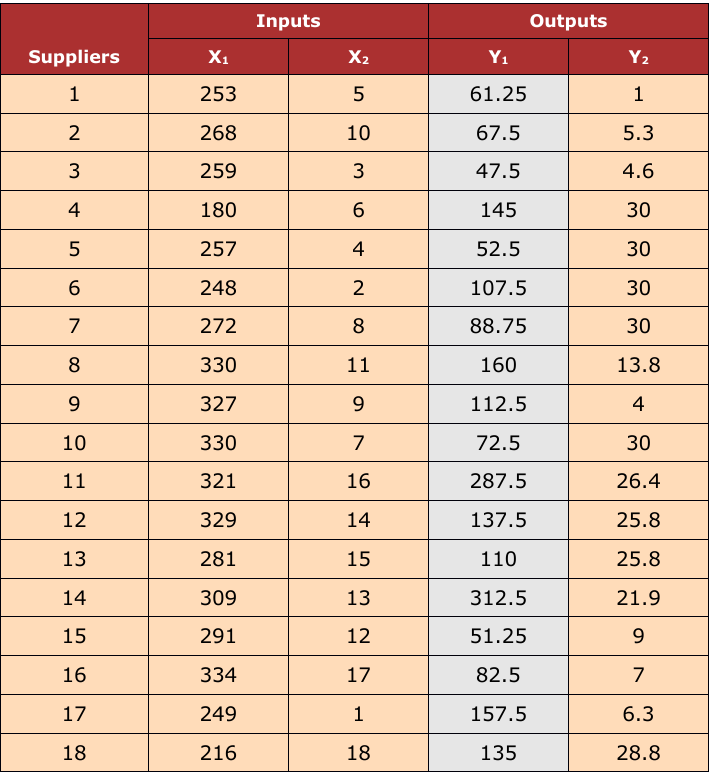
Table 4. Original values for α = 0.75